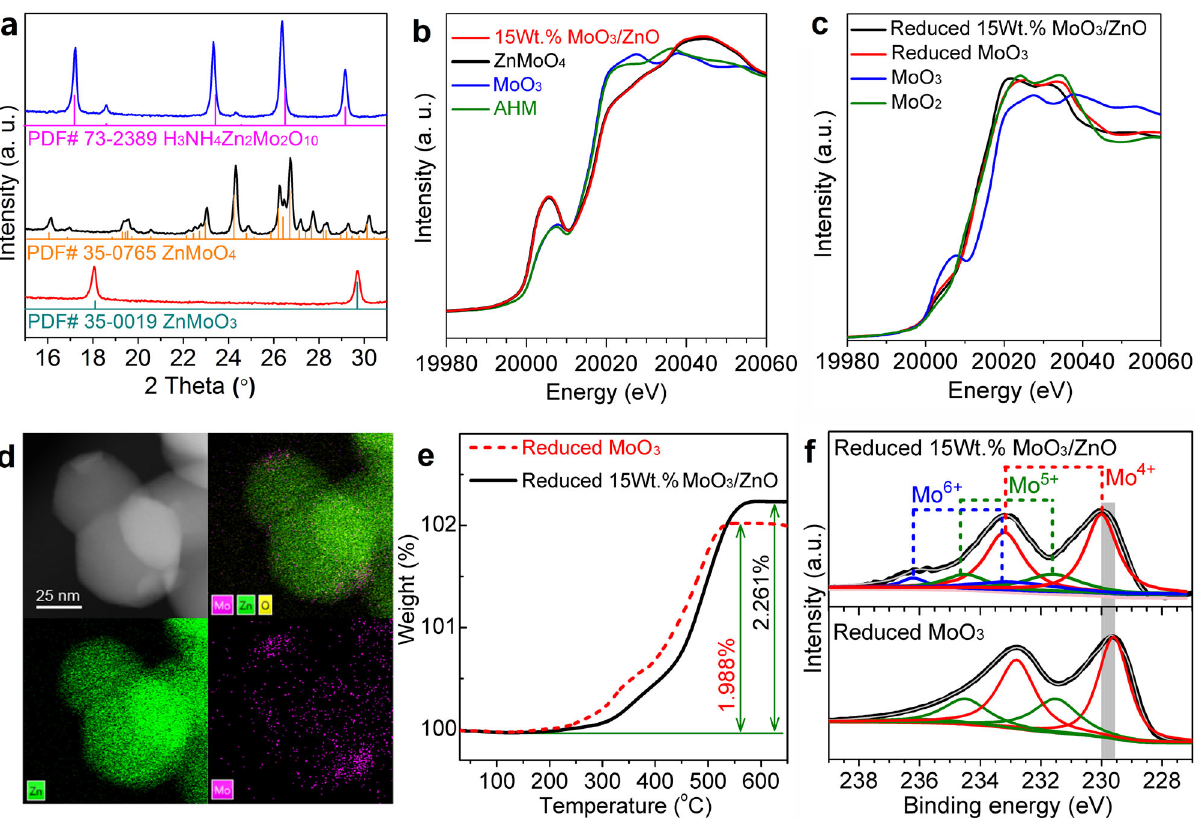
Fig. 2 Characterization results of catalysts. a XRD patterns of the as-prepared (blue line), calcined (black line), and reduced (red line) 15wt.%MoO 3 /ZnO catalysts. b Normalized XANES spectra at the K-edge of Mo of the 15wt.%MoO 3 /ZnO catalyst and three reference compounds (ZnMoO 4 , MoO 3 , and AHM). c Normalized XANES spectra at the K-edge of Mo of the reduced MoO 3 , 15wt.%MoO 3 /ZnO catalyst and two reference compounds (MoO 3 and MoO 2 ). d STEM image and elemental mappings of the reduced 15wt.%MoO 3 /ZnO catalyst. e TG pro fi les of the reduced MoO 3 and 15wt.%MoO 3 /ZnO catalysts in fl owing air. f Mo 3 d core level XPS spectrum of the reduced MoO 3 and 15wt.%MoO 3 /ZnO catalysts. 15wt.%MoO 3 /ZnO represents that the mass of Mo element in the catalyst accounts for 15% of the total